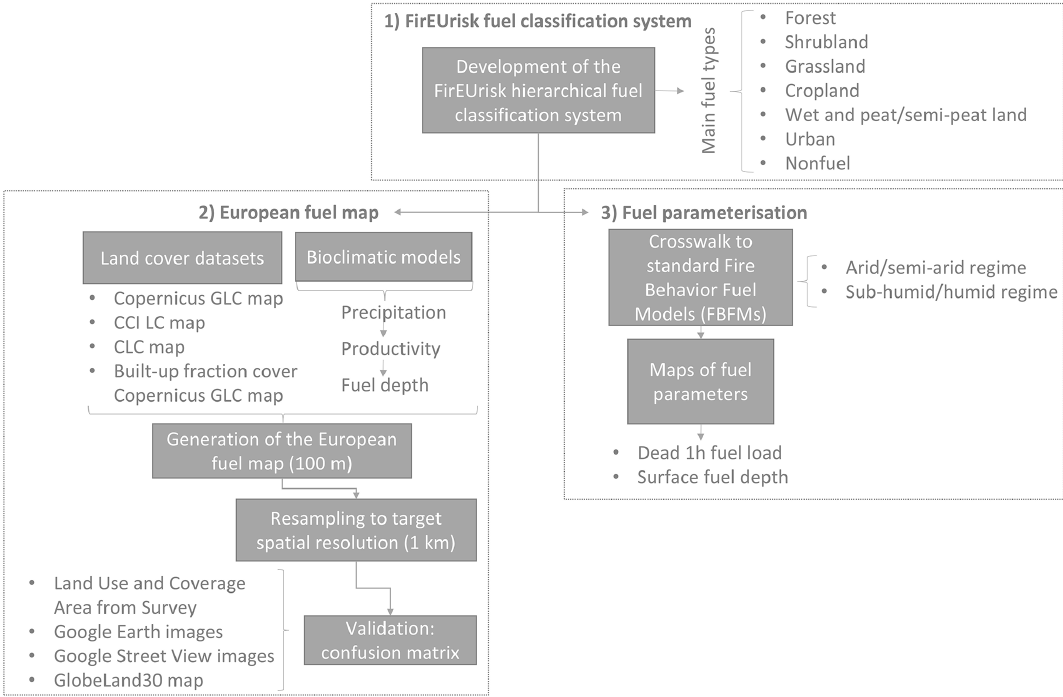
Figure 1. General overview of the structure of this